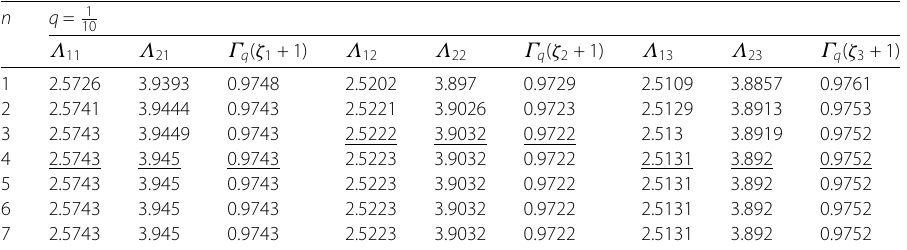
Table 2 Some numerical results of Λ 1 i , Λ 2 i , and Γ q ( ζ i + 1) in Example 1 for q = 1